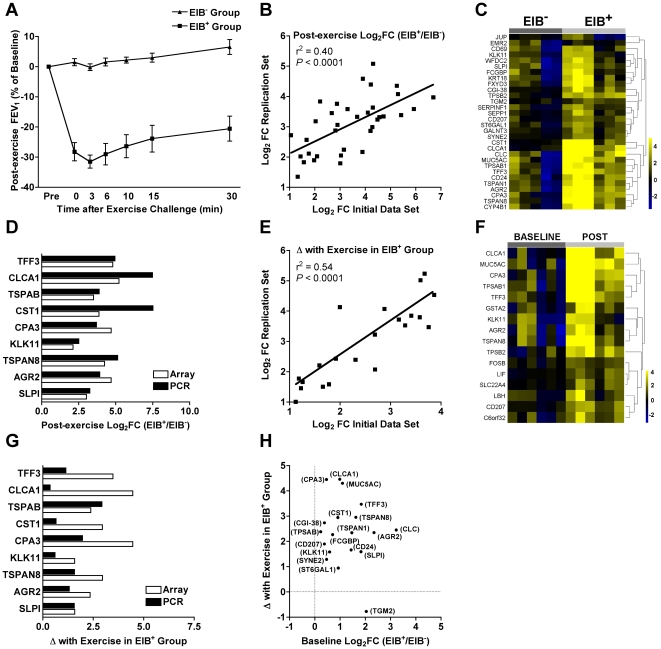
Comparison of lung function and gene expression between asthmatics with EIB and an asthmatic control group without EIB.The severity of EIB was markedly greater in the EIB+ group (A). Genes that were increased in the EIB+ group relative to the EIB− group post-exercise were consistently differentially expressed in the initial and replication cohorts as shown by the strong association between differences in gene expression in each cohort (B). A heatmap of these genes shows the Log2FC relative to the average expression for each gene in each individual of the two groups post-exercise (C). The fold difference in gene expression between the groups post-exercise identified by the microarray platform was similarly demonstrated by qPCR (D). Within the EIB+ group, genes that increased in response to exercise challenge were consistently increased in the initial and replication cohorts (E). A heatmap of these genes shows the Log2FC relative to the average expression for each gene in each individual of the EIB+ cohort (F). The fold increase in gene expression in response to exercise challenge by the microarray platform was similarly demonstrated by qPCR with the exception of CLCA1 and KLK11 (G). To visualize the differences in the pattern of gene expression, differences in gene expression between the groups at baseline are plotted against the change in gene expression with exercise challenge in the EIB+ group (H).